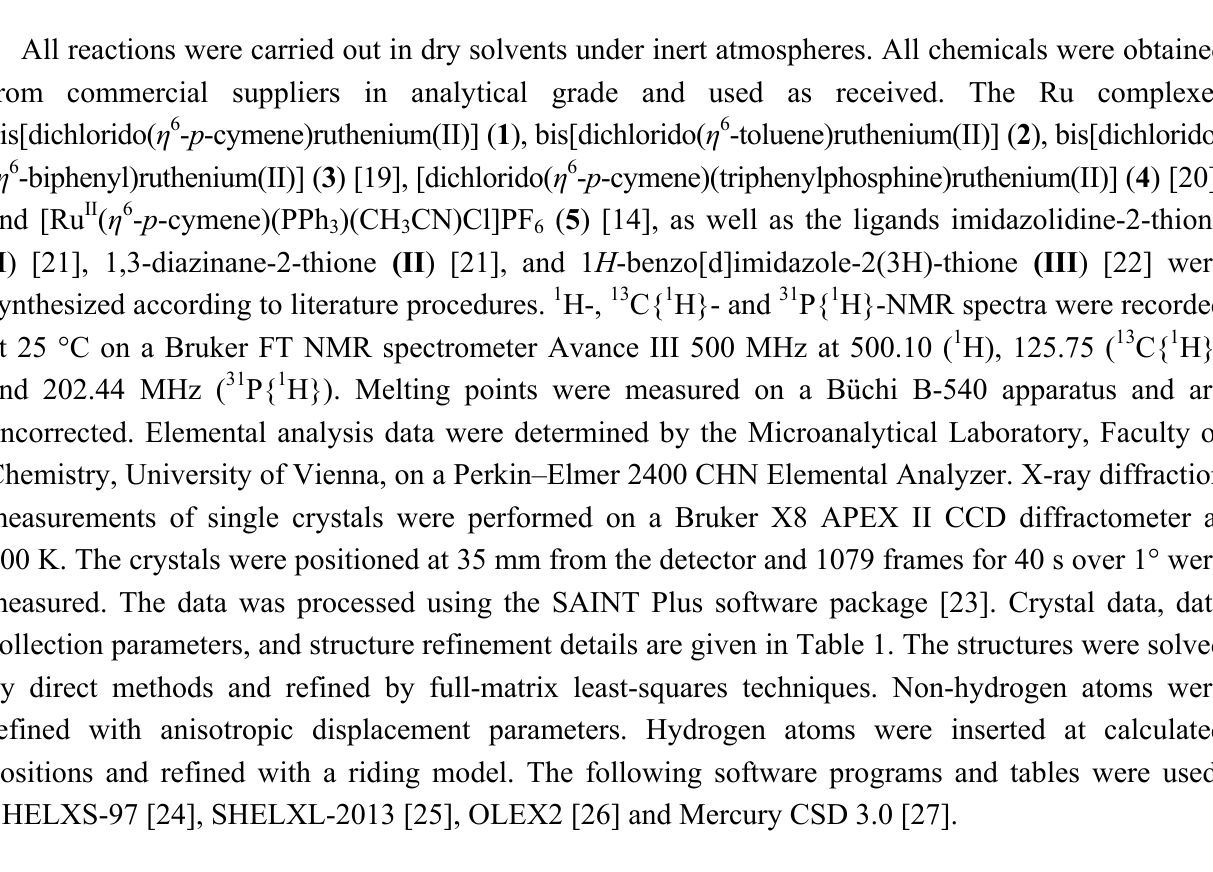
(µM) of thiourea derivatives and their Ru complexes 50